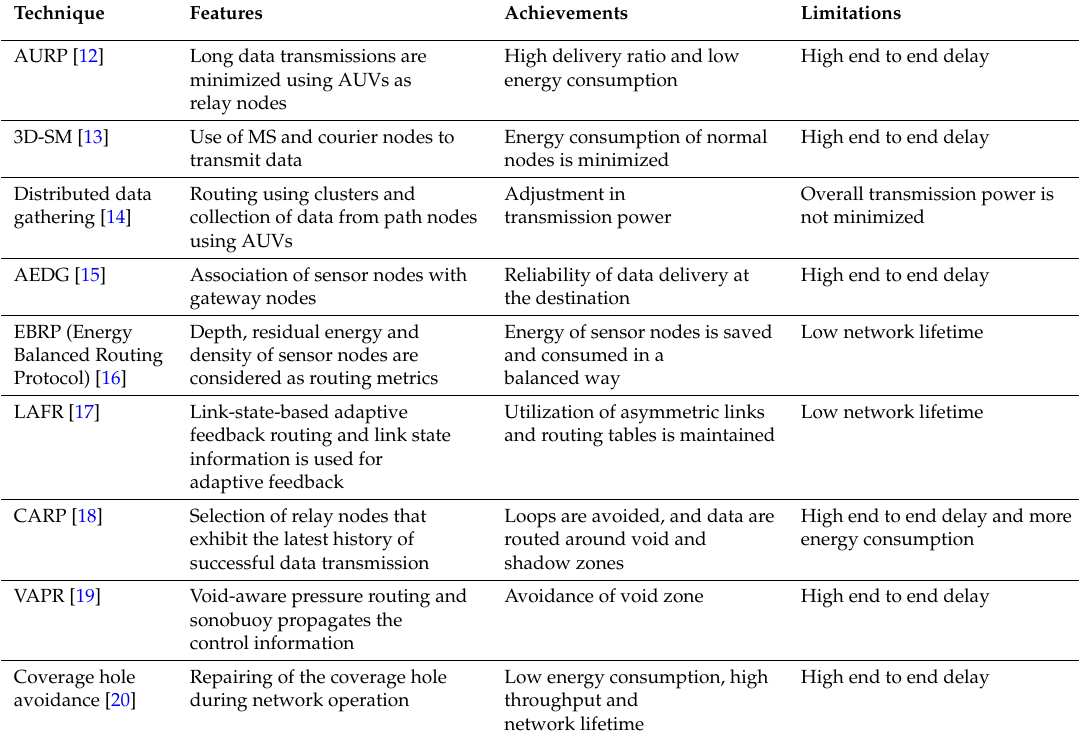
Table 2. Performance tradeoffs in existing mobility-based routing protocols. AURP, AUV-aided underwater routing protocol; SM, sink mobility; AEDG, an efficient data-gathering; CARP, channel-aware routing